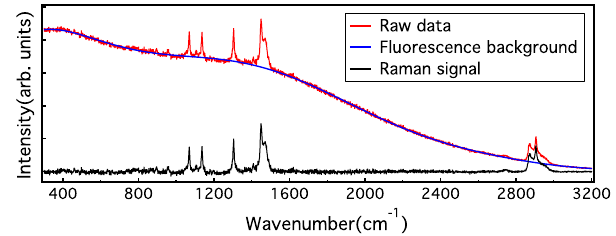
FIG. 5. The background (blue line) is a polynomial fit of the peakless region of the raw data. The black line is the residue after subtracting the background.